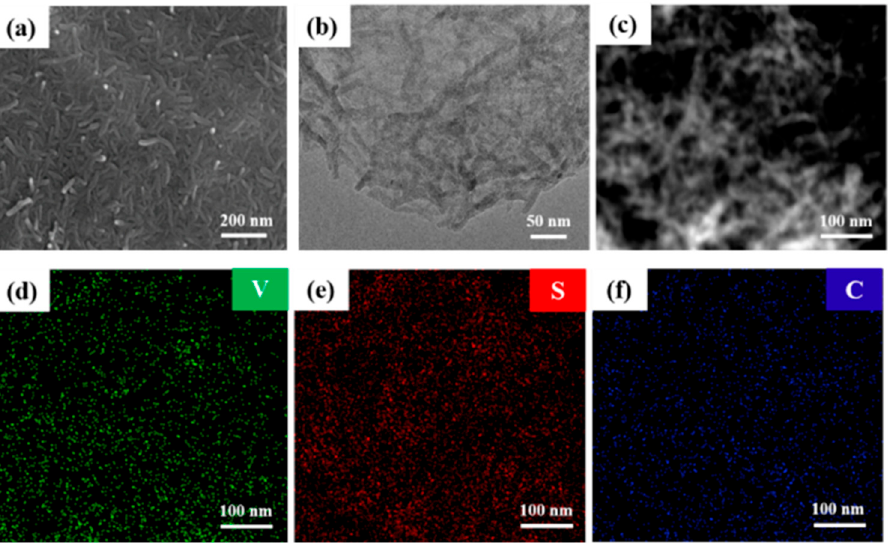
Figure 3. The morphology features of VS 4 /RGO nanocomposites: ( a ) FESEM images; ( b ) TEM images; ( c – f ) EDX elemental mapping images of VS 4 /RGO nanocomposites:( d ) V, ( e ) S, ( f ) C.